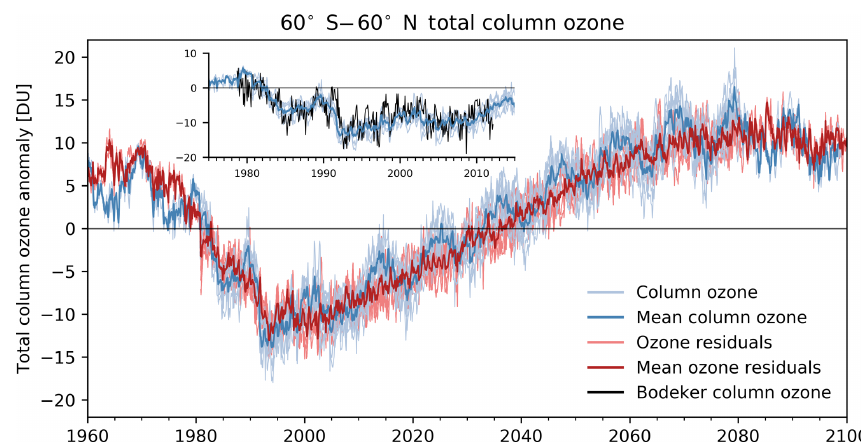
Figure 1. Deseasonalised total column ozone anomalies (in DU) relative to the 1980 mean, averaged over 60 ◦ S–60 ◦ N, for the seven UM- UKCA transient ensemble members (light blue lines) and ensemble mean (dark blue line). Also shown are the ozone residuals calculated when natural cycles are removed from each ensemble member (light red lines) and the mean of the ozone residuals (dark red line). The inset shows total column ozone anomalies for the transient UM-UKCA simulations and v2.8 of the Bodeker dataset (Bodeker et al., 2005; black line) from 1975 to